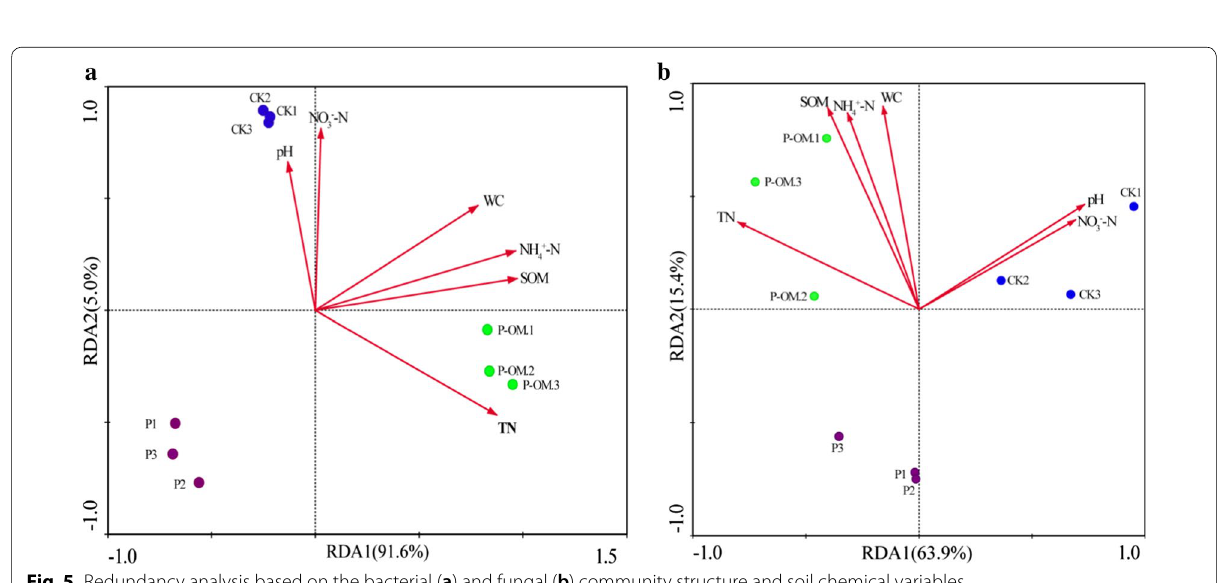
Table 5 Eigen values, F values and